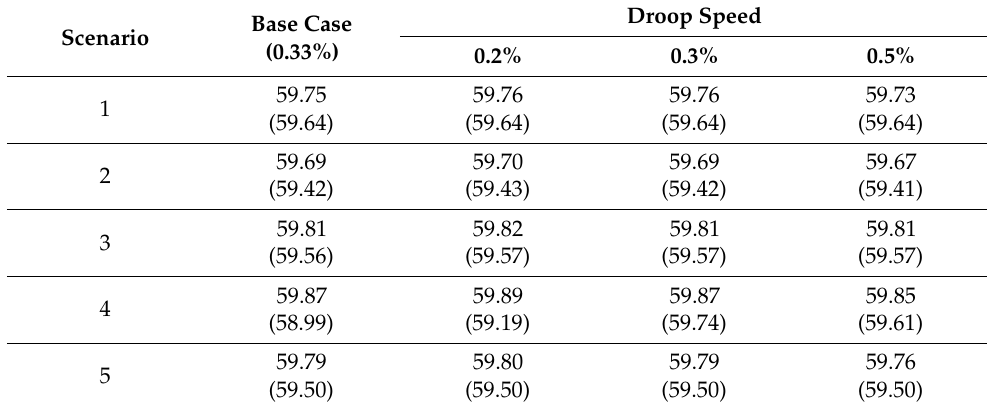
Table 7. Lowest frequency per parameter (droop control) (Hz): three-phase short